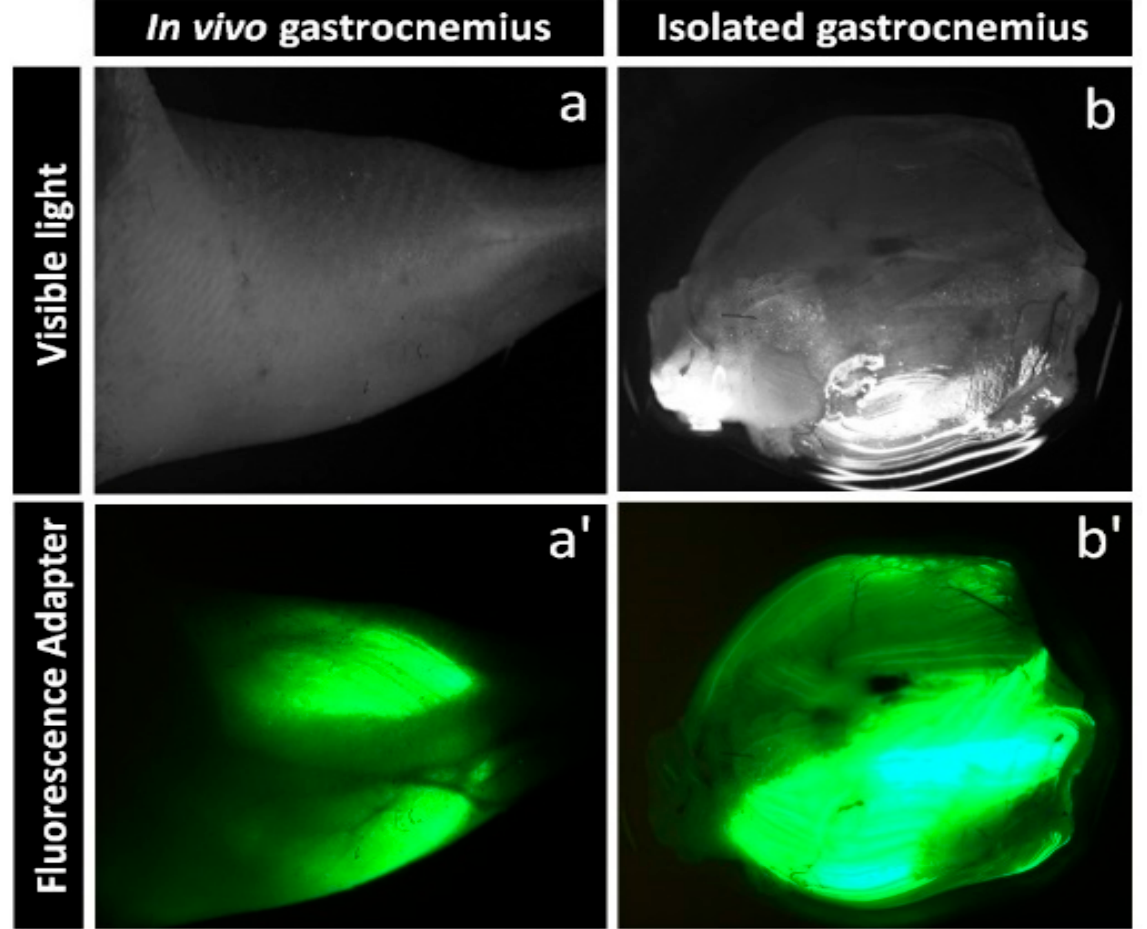
Figure 1. Green fluorescent protein (TurboGFP) in mouse muscle at 6 weeks after plasmid transfec- tion and electroporation: ( a ) visible light photo of a mouse hindlimb; ( a’ ) transcutaneous TurboGFP fluo- ( b’ ) TurboGFP fluorescence of isolated gastrocnemius. Fluorescence stereomicroscopy performed with Nightsea SFA-RB-GO fluorescence adapter/DeltaPix Invenio 5SIII CMOS